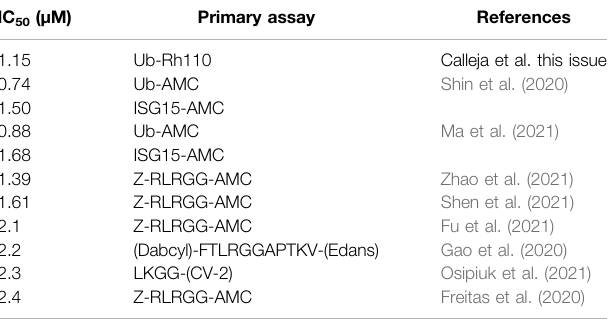
TABLE 2 | Currently reported potencies (IC 50 , µM) of GRL-0617 against SARS- CoV-2 PLpro. IC 50 (µM)